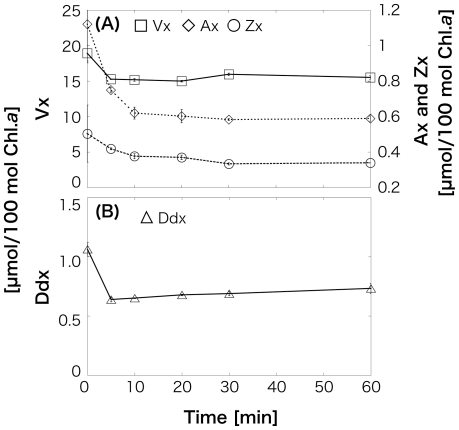
Time course of xanthophyll cycle pigment changes in a cell suspension of Ochromonas itoi in low-light (LL) during 1-h illumination after 6-h high-light (HL) illumination.Pigments are normalized to chlorophyll a (Chl.a). Values are means of three independent records, and error bars are standard deviations. A, Epoxidation of zeaxanthin (Zx) from antheraxanthin (Ax) to Vx; B, epoxidation of diatoxanthin (Dtx) to diadinoxanthin (Ddx).